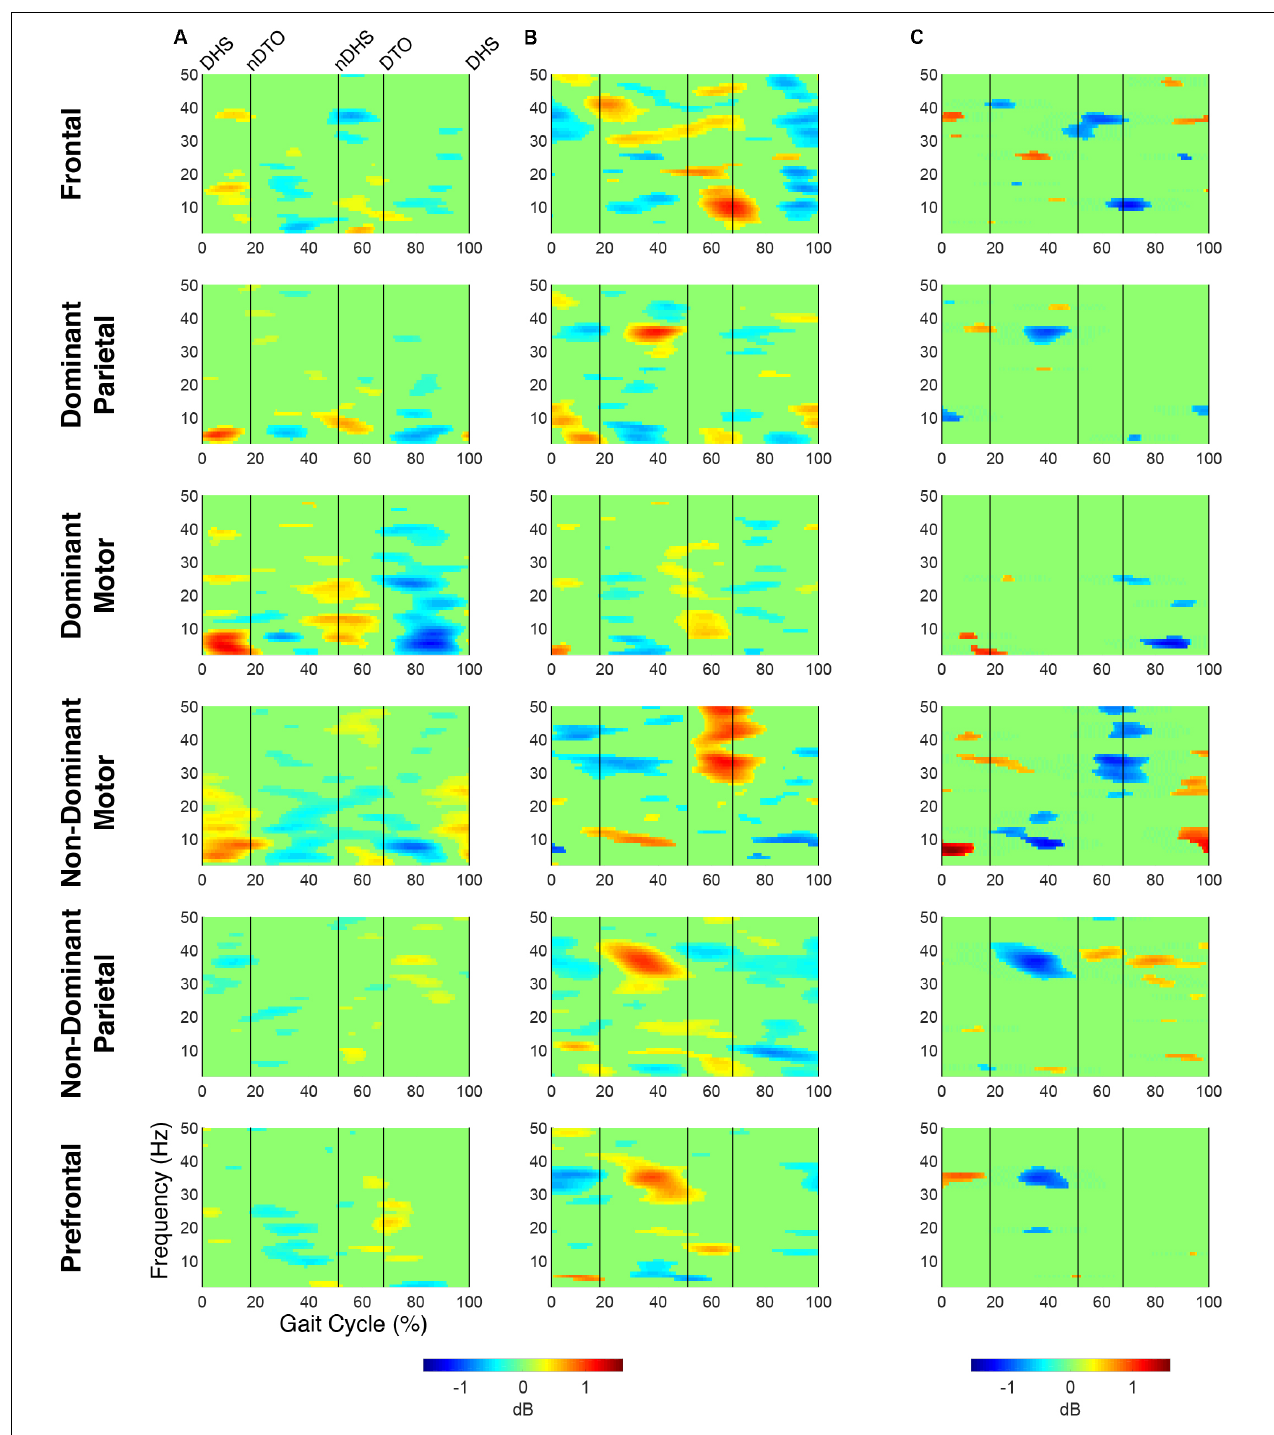
FIGURE 1 | Time-frequency modulations relative to mean gait cycle activity during treadmill walking. Grand mean gait event related spectral perturbations (ERSPs) computed for each cortical cluster in (A) TD and (B) CP, displayed in dB. (C) Between group differences of spectrograms calculated by subtracting grand mean ERSPs in CP from TD, displayed in dB. ERSPs and difference spectrograms were masked for significance (alpha < 0.05); non-significant values were set to 0 dB (green).